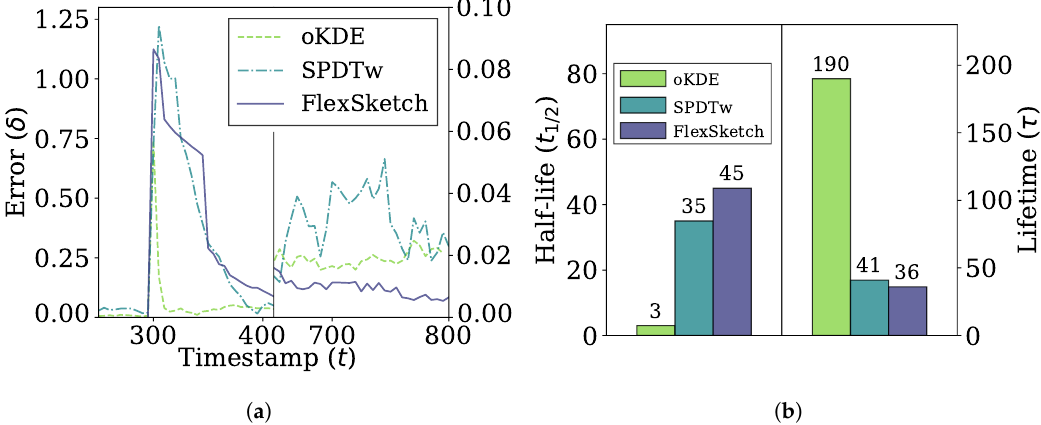
Figure 6. Error and adaptability performance under sudden concept drift. ( a ) Change of the error over time. The period between about 400 and 650 is omitted for better visualization, and the error after t “ 650 is magnified with the scale at the right side. ( b ) Half-life (left side) and lifetime (right side). A smaller value is